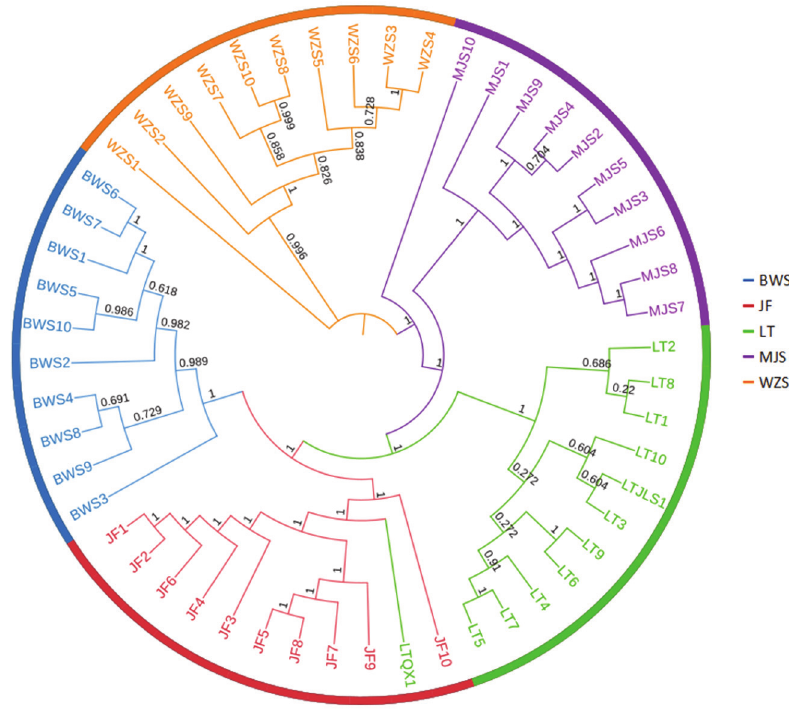
Figure 3. Phylogenetic tree of the 52 P. bungeana individuals using SNP data.